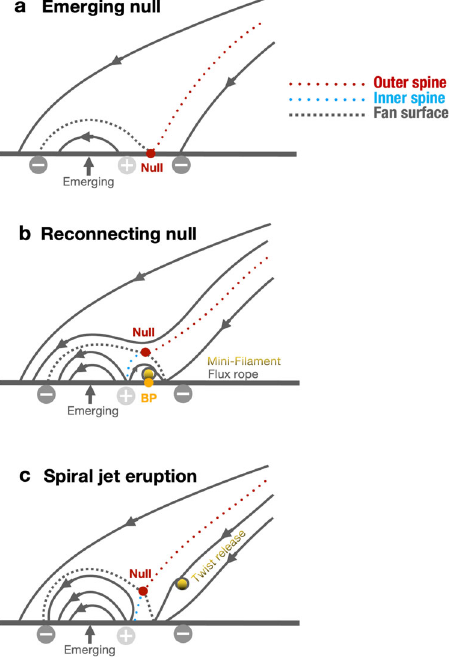
Fig. 7 | Schematic drawing for the evolution of the null-point. Magnetic fi eld lines in a vertical plane through the null-point from the emergence ( a ) to recon- nectionphase( b ),aswellastheeruptionofthemini- fi lamentandinducedspiraljet ( c ). The null-point and bald patche are denoted by dots in red and orange, respectively.The dotted linesinred and blue represent the outerand innerspines, respectively.Thedashedseparatrix fi eldlinesdenote fansurfacein3D.Thedotsin gold indicate the twisted fl ux and mini- fi